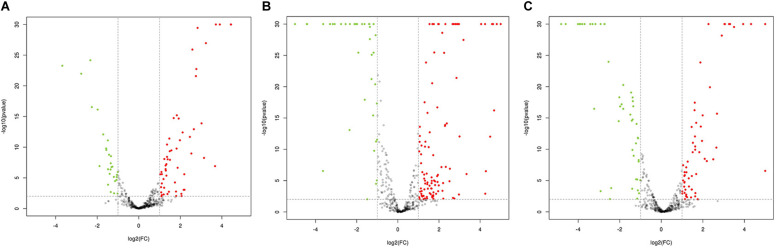
Volcano plot of pairwise comparisons between samples. (A) Volcano plot of the comparisons between IA (Mutants with weak activity) and MA (Mutants with maximum activity); (B) Volcano plot of the comparisons between NA (Wild-type strain) and MA (Mutants with maximum activity); (C) Volcano plot of the comparisons between NA (Wild-type strain) and IA (Mutants with weak activity).